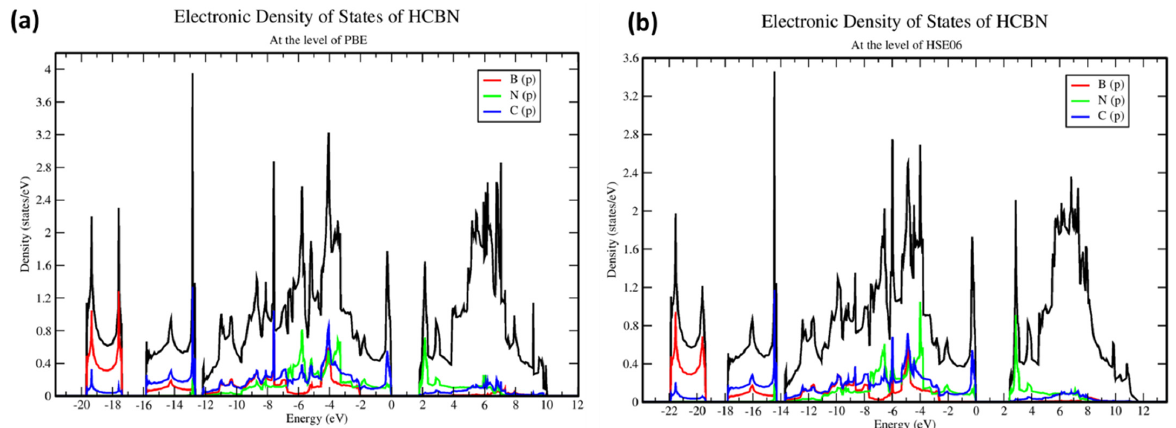
Figure 3. Electronic density of states (DOS) and partial density of states (PDOS) of HCBN calculated at the ( a ) PBE and ( b ) HSE06 levels.